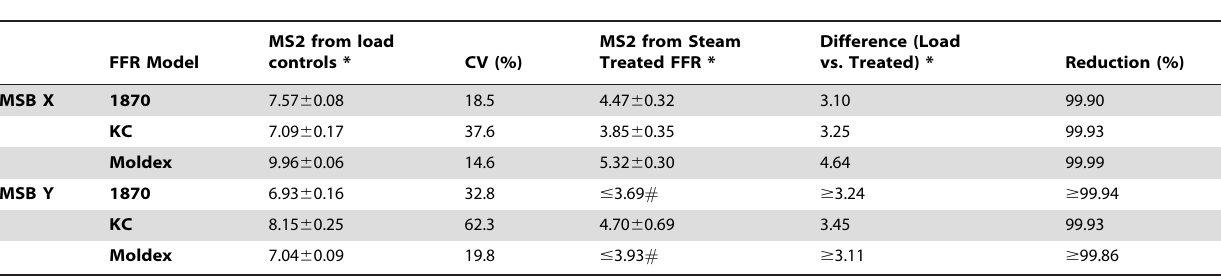
Table 3. Decontamination efficacy of the microwave steam